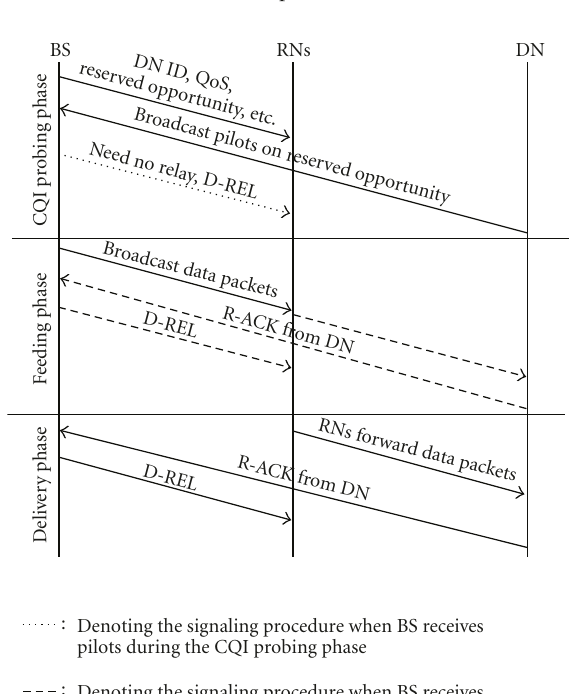
Figure 5: Illustration of the proposed BROAD